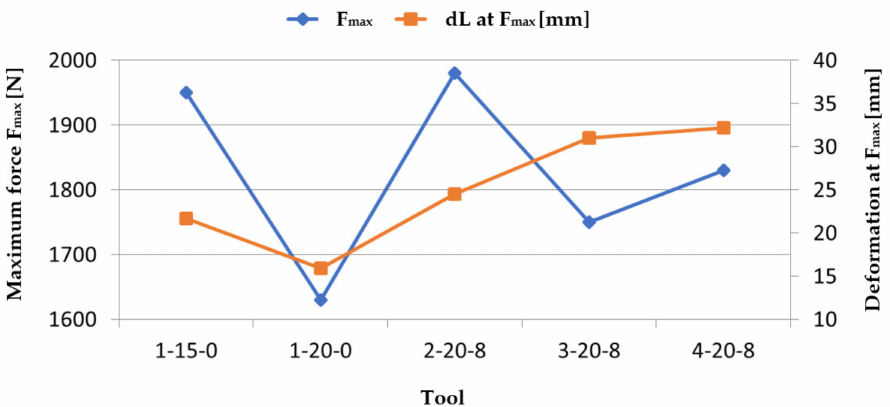
Figure 18. Results of the comparative three-point bending test on material EN AW 5083 H111.